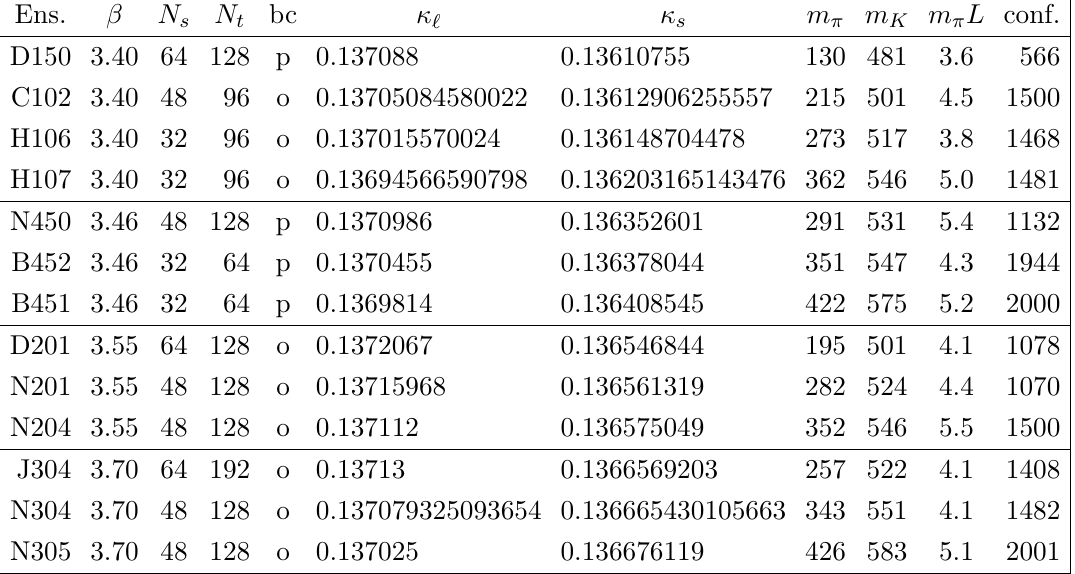
Table 7 . The same as table 6, but for the m s = phys : trajectory. Ens.